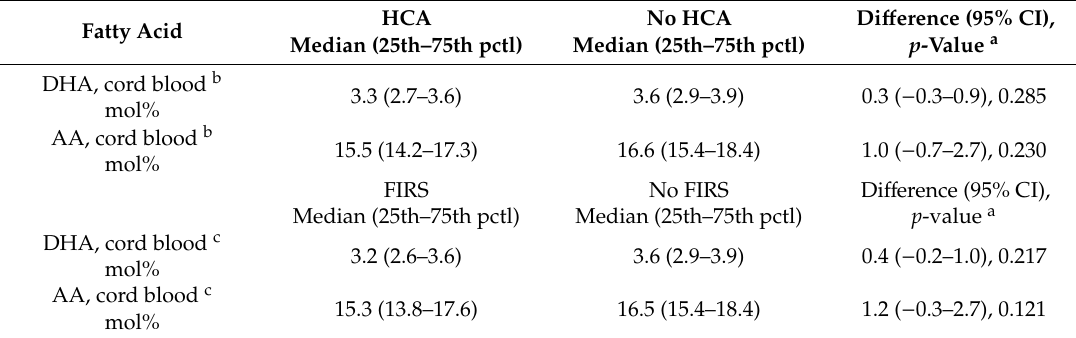
Table 3. Levels of DHA and AA in cord blood, in infants with and without histological signs of chorioamnionitis and fetal inflammation